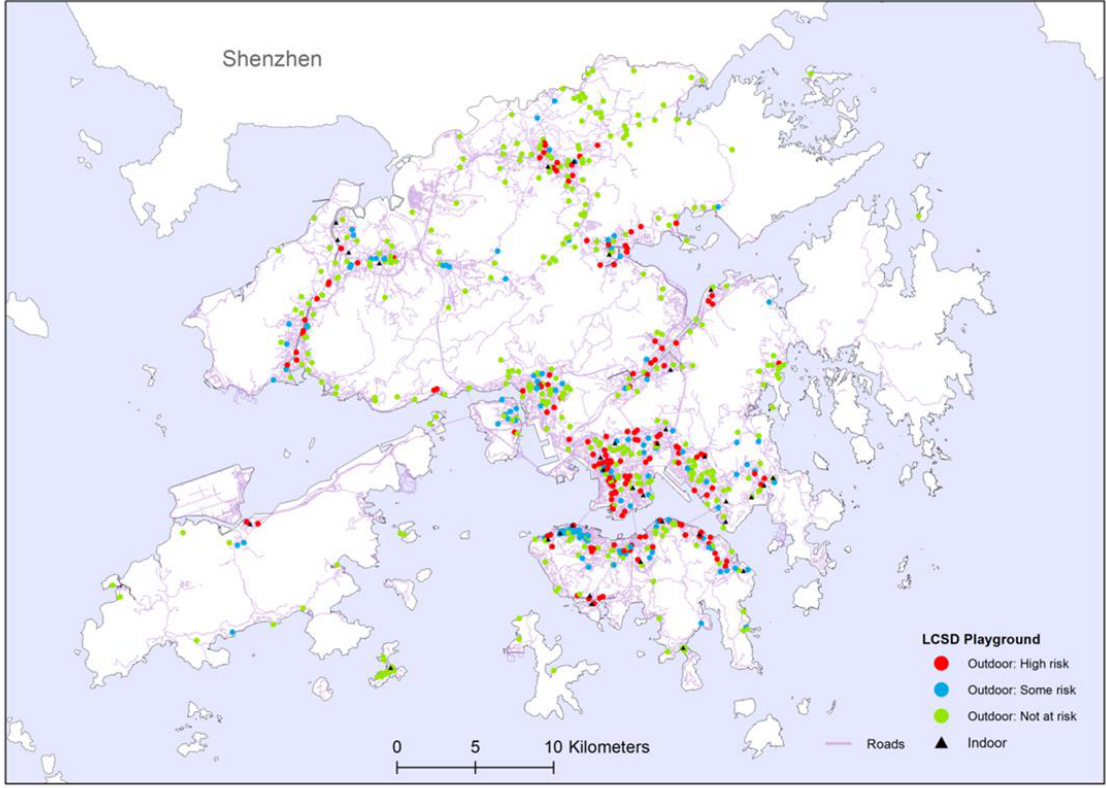
Figure 4. Playgrounds by risk levels by districts and regions of Hong Kong, 2016. Note: Risk in this